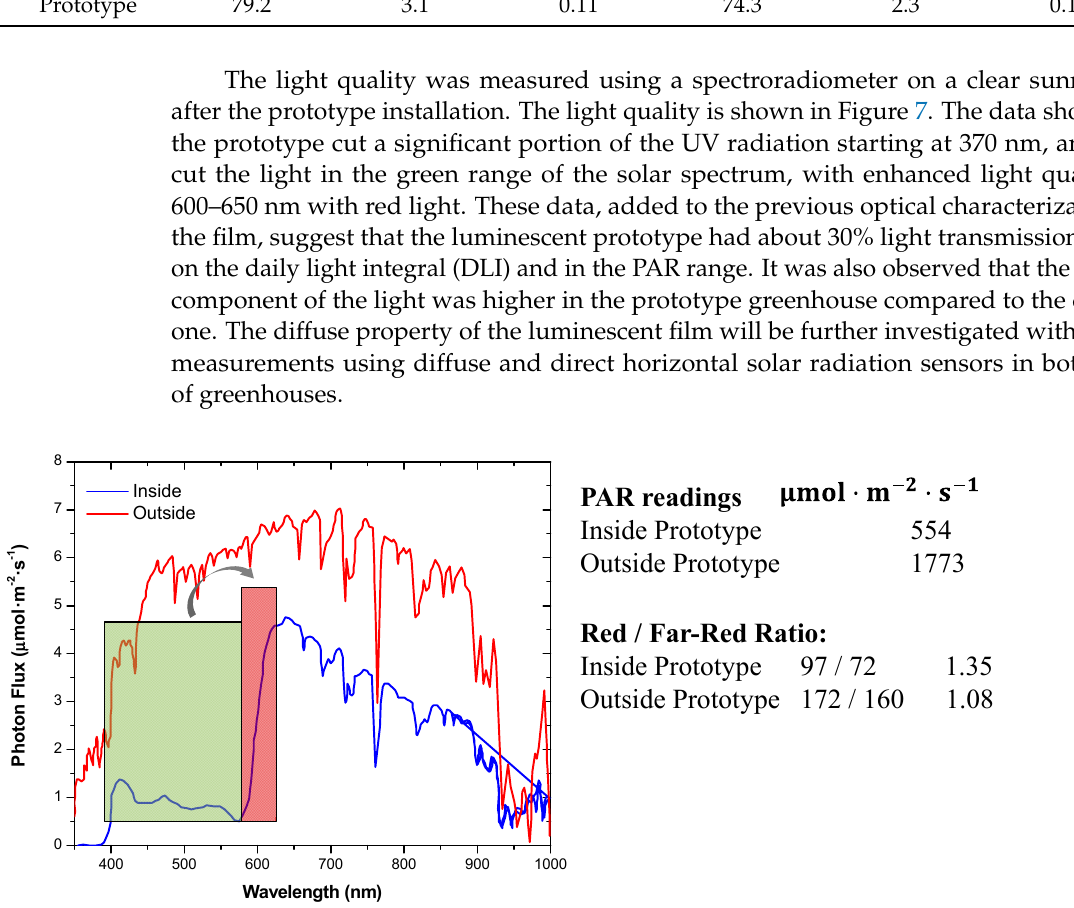
Figure 7. Light quality under the prototype greenhouse, using luminescent-doped LDPE films coupled to 1DPC